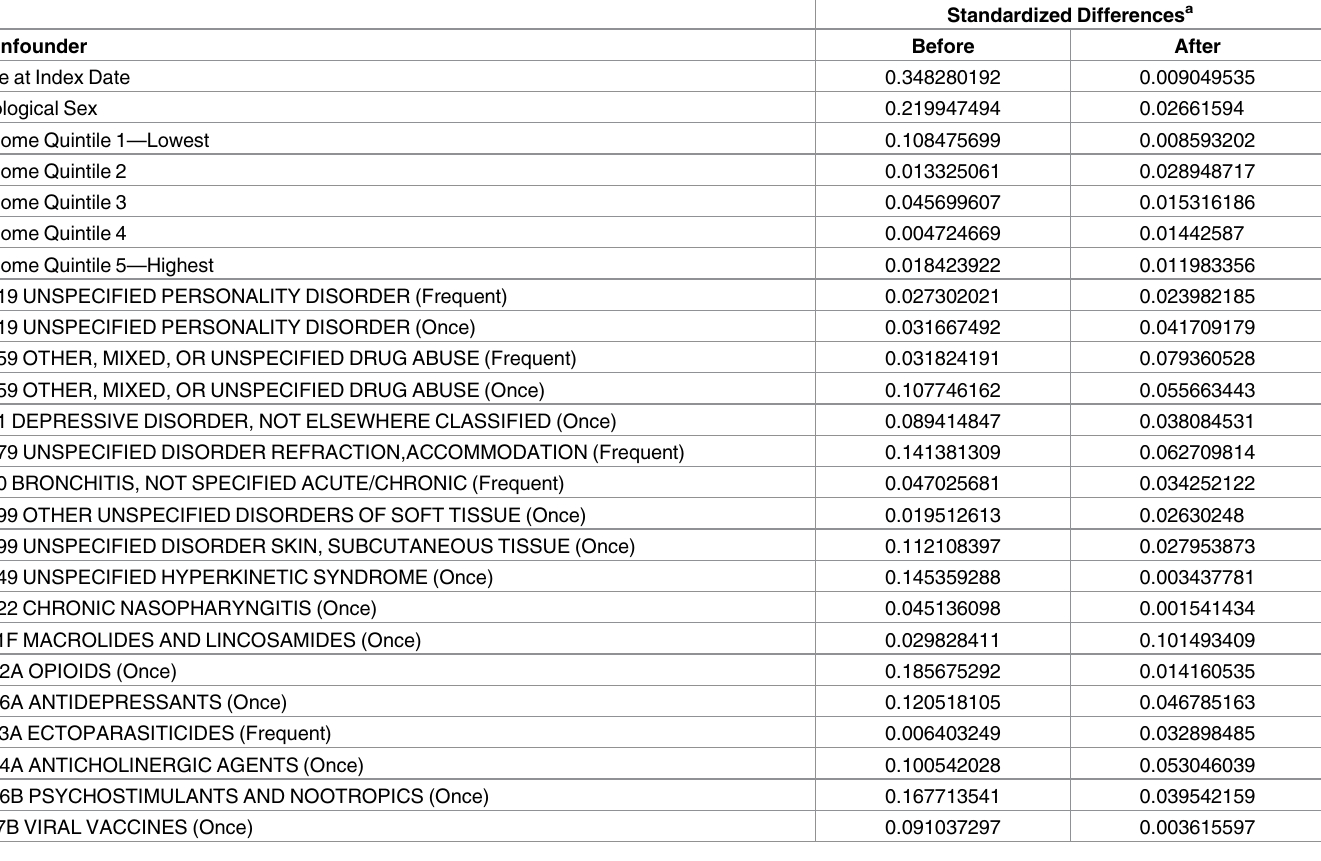
Table 1. Confounders adjusted for in propensity score